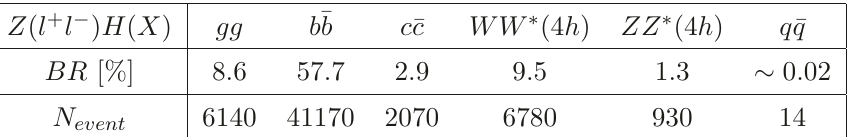
Table 2 . The decay branching ratios of the SM Higgs boson with a mass of 125 GeV to different hadronic channels [39] and the corresponding expected numbers of events in ZH production, with subsequent decays at a e + e − collider with √ s = 250 GeV and an integrated luminosity of 5 ab − 1 . Only decays of the associated Z boson to electrons and muons are included. h represents any of the quarks except the top quark and q are light